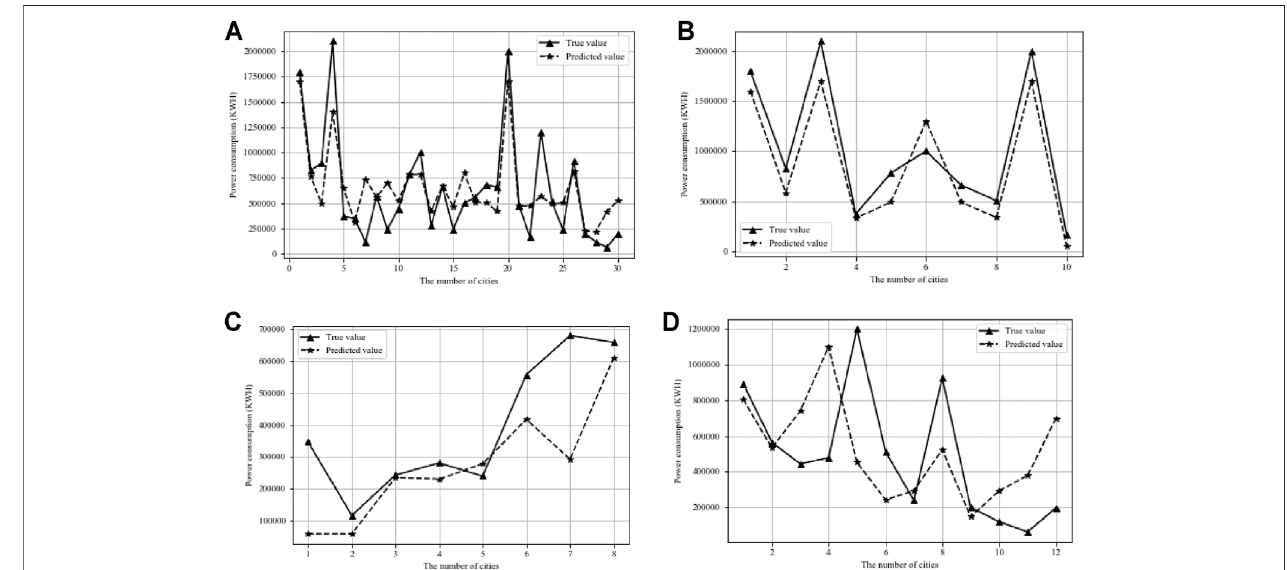
FIGURE 5 | Non-linear forecast results for national urban household electricity